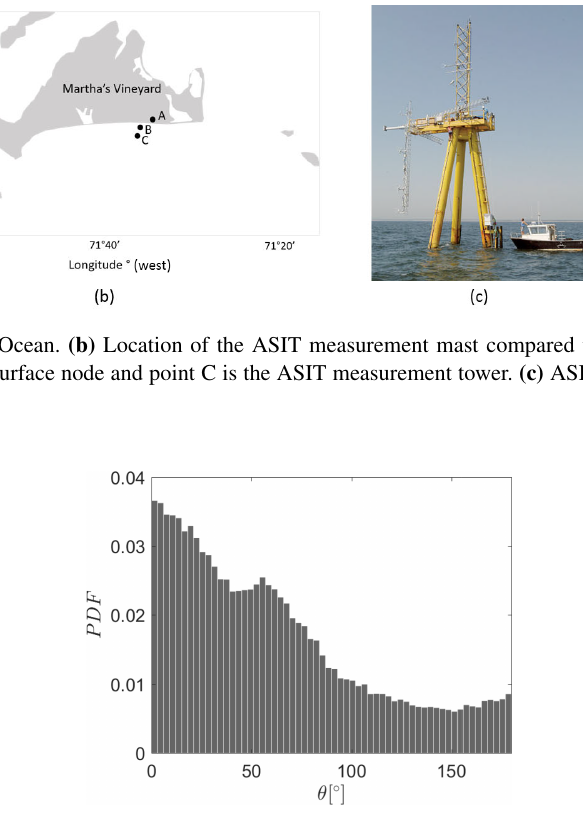
Figure 4. Probability density function (PDF) of the angle between the wind and peak wave direction for both ASIT and FINO mea-